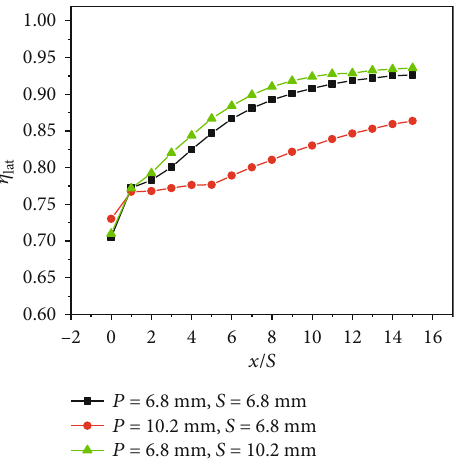
Figure 20: In fl uence of pin fi n diameter on cooling e ffi ciency distribution.